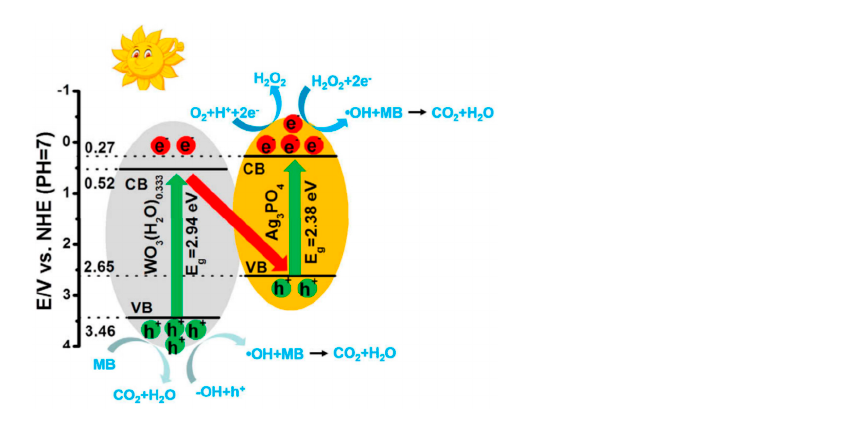
Figure 5. The photocatalytic mechanism of WO 3 (H 2 O) 0.333 /Ag 3 PO 4 composites under visible light [44].